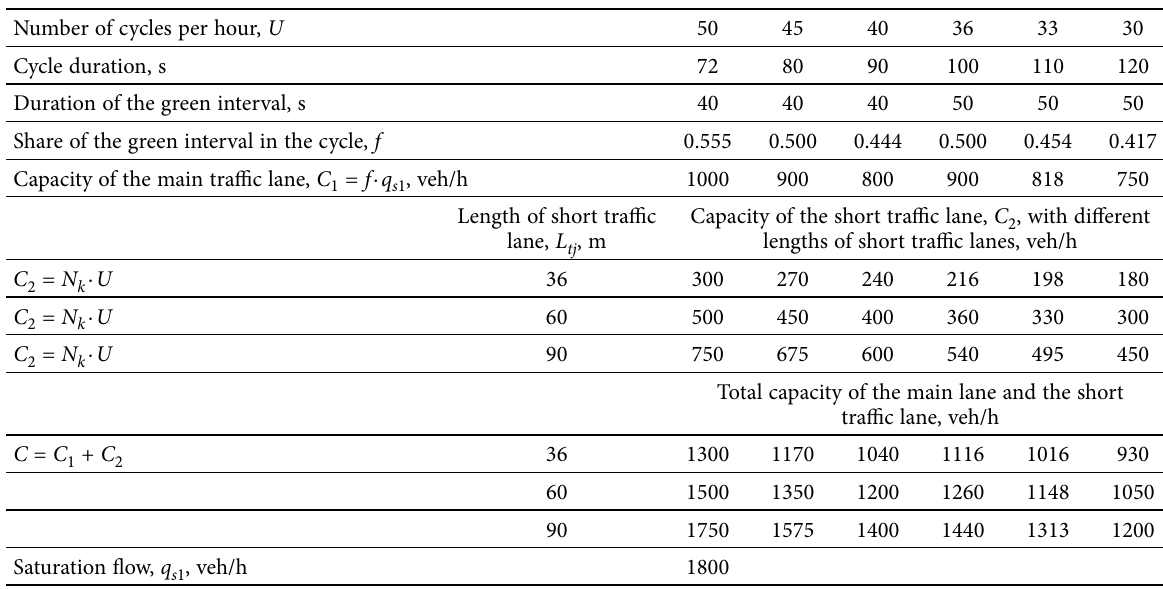
Saturation flow, q s 1 , veh/h Table 5. Quality assessment of a short traffic lane performance depending on the vehicle idle time t w (Holz-Rau, Brandt 2009) Level of service